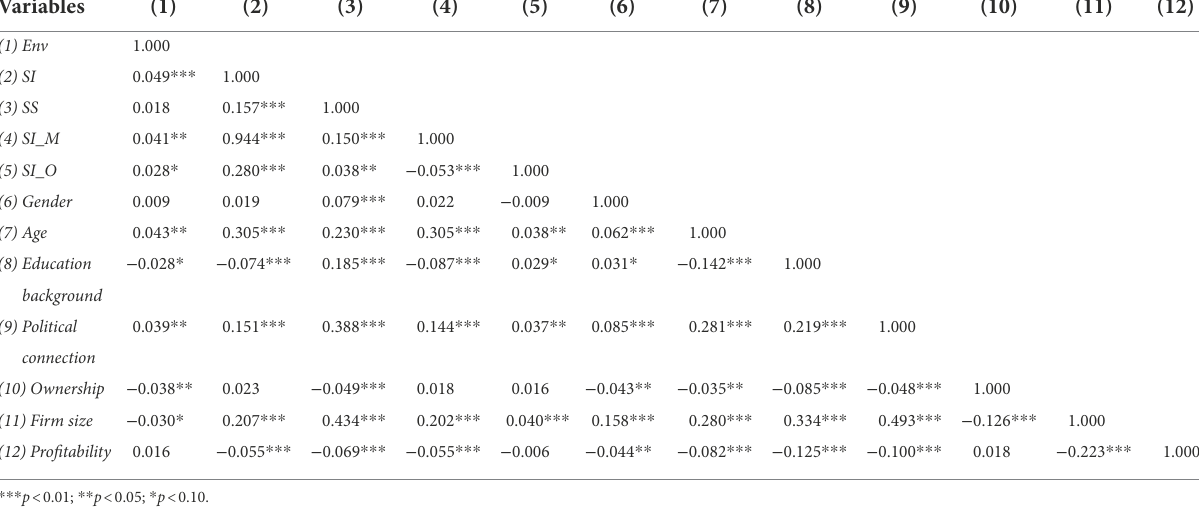
TABLE 3 Correlations.